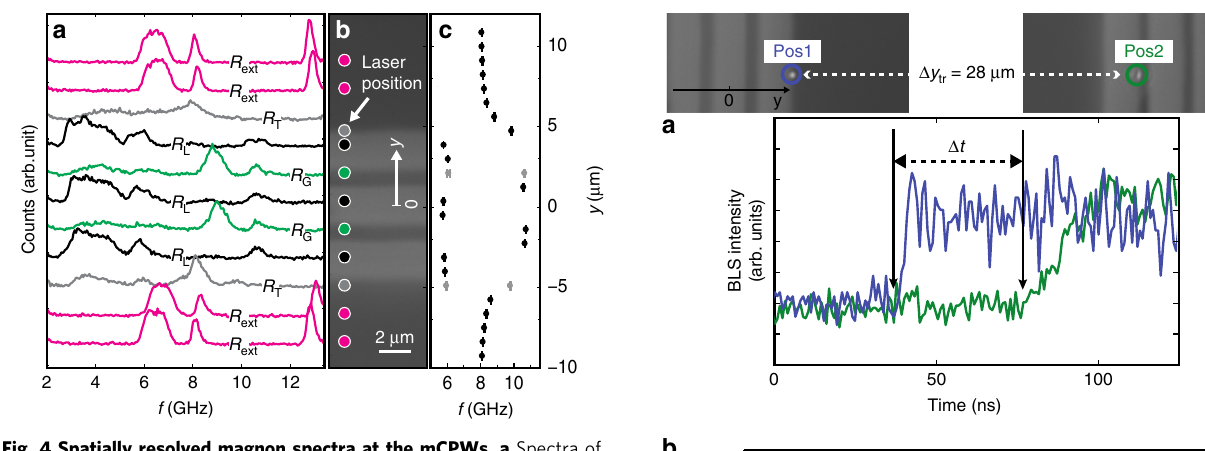
Fig. 4 Spatially resolved magnon spectra at the mCPWs. a Spectra of thermally excited magnons in sample 1 measured by μ BLS for μ 0 H = 0.15 T and θ = 90° at different laser-spot positions indicated by circles in the b optical image taken by the BLS microscope. The systematic variation of spectra depending on laser-spot positions is color-coded consistently in a and b . c Variation of the frequency attributed to the PSSW1 mode along the path of BLS spectroscopy (black and gray symbols). The gray symbols indicate spectra taken at the boundary between regions R G and R L . In this case, the spectra contained two PSSW1 peaks which were consistent with YIG subjected to either high or low effective fi eld. We attribute this observation to the fi nite diameter of the BLS laser beam probing two regions at the same time. Peak positions were extracted by locally fi tting the magnon spectra with a Gaussian function, error bars indicate the standard deviation of the fi t. Source data are provided as a Source Data fi le. fi eld H was applied at θ = 90°, i.e., the magnetization M was parallel to k and magnons propagated in backward volume